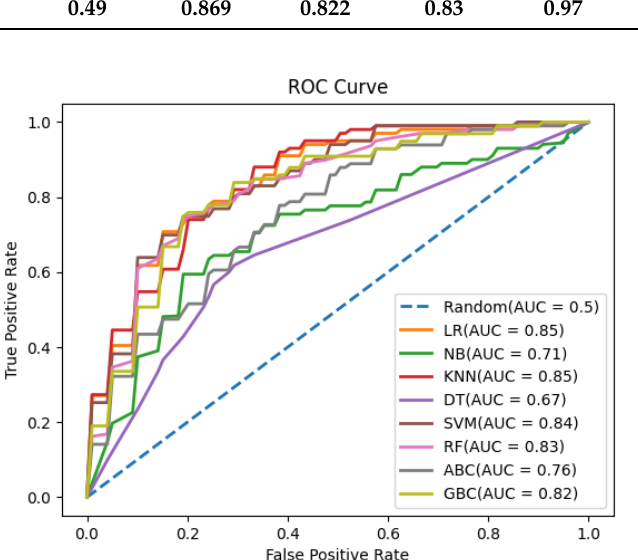
Figure 2. Performance measures for different machine learning methods using the inde- pendent dataset and the AAC and DPC features. 2.3. Comparison with Other Methods The existing methods, such as Ding et al., achieved an accuracy of 85.02% on the training dataset but an accuracy of only 71.3% on the independent dataset [13]. Similarly, Manavalan et al., Tan et al., and Charoenkwan et al. achieved accuracies of 87%, 87.95%, and 92.52% on the training dataset, respectively (shown in Table 3). These above methods achieved accuracies of 79.8%, 75.53%, and 77.66%, respectively, on the independent da- taset [12,15,16]. The above results suggested that these methods could achieve high accu- racies on the training dataset but are unable to attain similar accuracies on the independ- ent dataset. The proposed method achieved an accuracy of 80% on the training dataset and an accuracy of 83% on the independent dataset. Therefore, in a real-life scenario, such as the independent dataset, our proposed method performed better than other existing